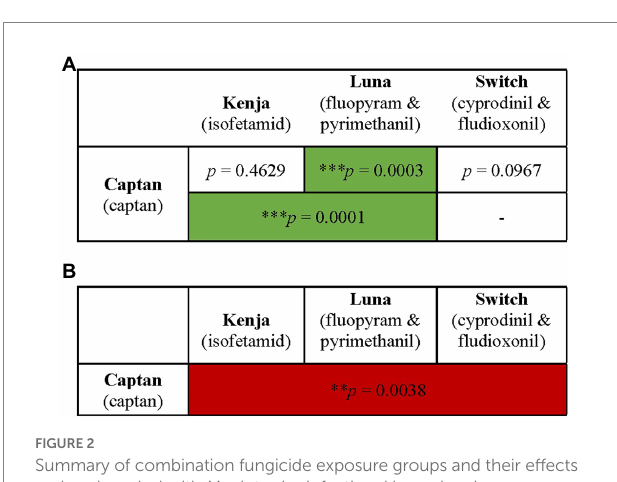
FIGURE 2 Summary of combination fungicide exposure groups and their effects on larval survival with M. plutonius infection. Honey bee larvae were exposed to combination of two, three (A) , or four (B) fungicide products [i.e., two, three, four (A) , or six (B) active ingredients]. Survival was monitored for 6 days (A) or 18 days (B) . ** and *** indicate significant effects on survival with p < 0.01 and p < 0.001, respectively by a Mantel–Cox log rank test (green boxes indicate significant increases in survival and red boxes indicate significant decreases in survival). Combinations not tested are indicated by